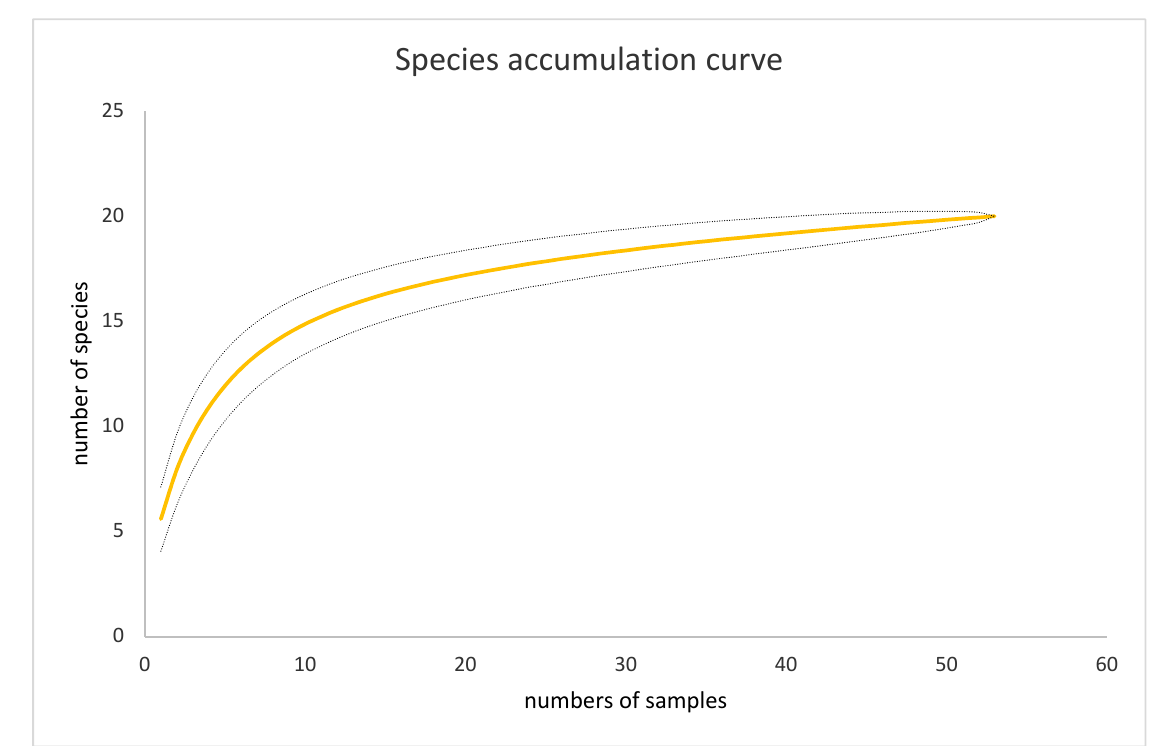
Figure 4. Species accumulation curve, represented with the yellow line and the 95% confidence interval dotted lines, displaying the data of 655 nests collected at 53 sites that contain 21 species of insect tenants that are associated with the use of mud nest.